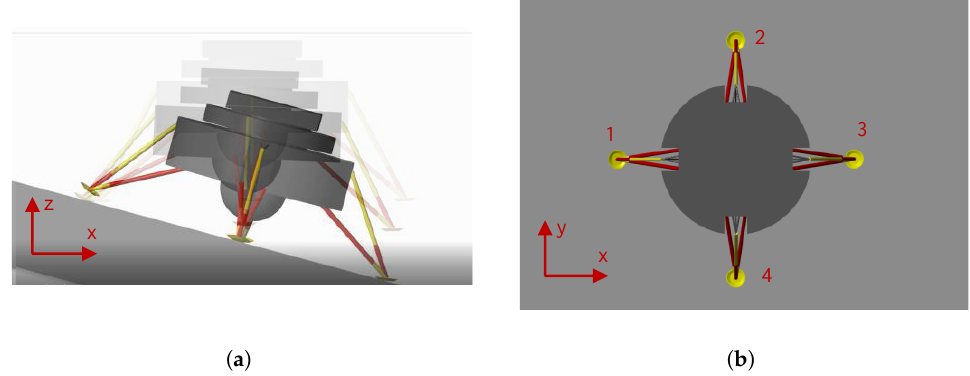
Figure 12. Landing impact animation, multi-body simulation. ( a ) Front view. ( b ) Top